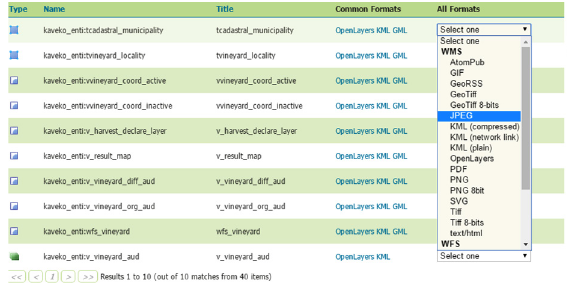
Figure 12. Layers offered through WMS service